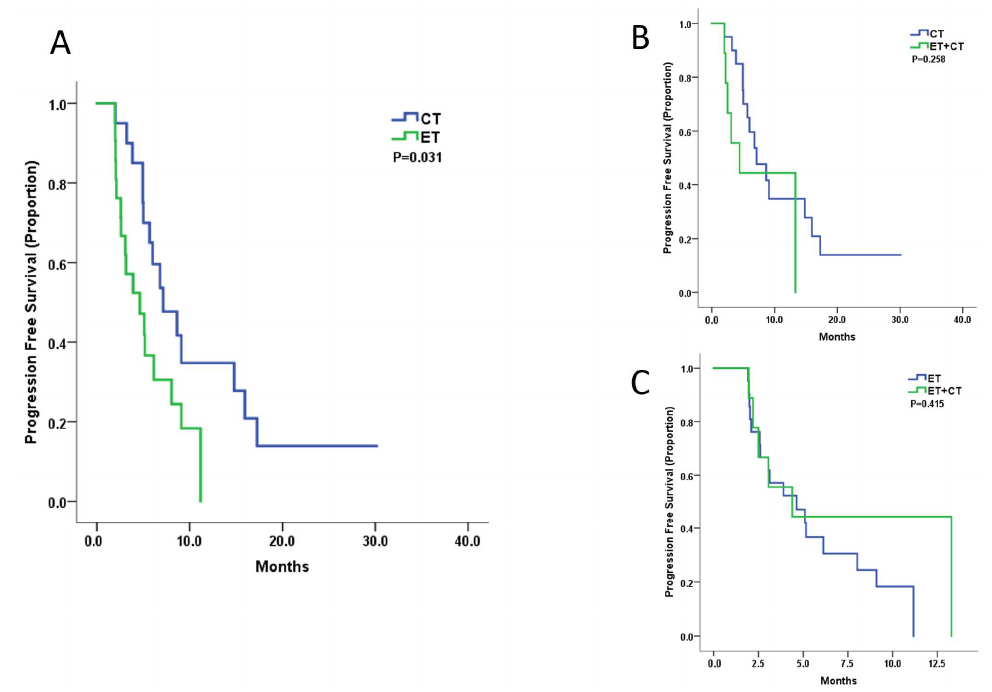
Figure 2. Kaplan–Meier curves for progression-free survival by treatment arm: ( A ). ET versus CT; ( B ) CT versus ET + CT; ( C ) ET versus ET + CT.